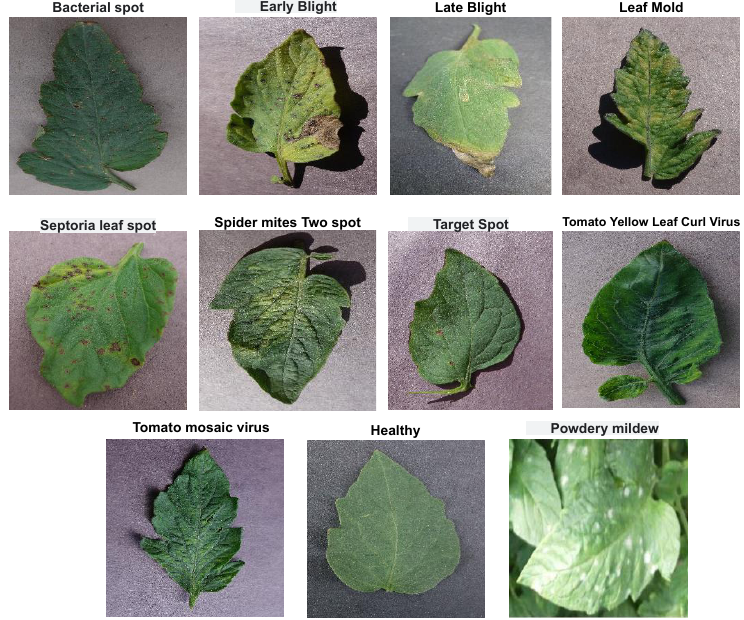
Figure 1. Sample of the first dataset used in the study.